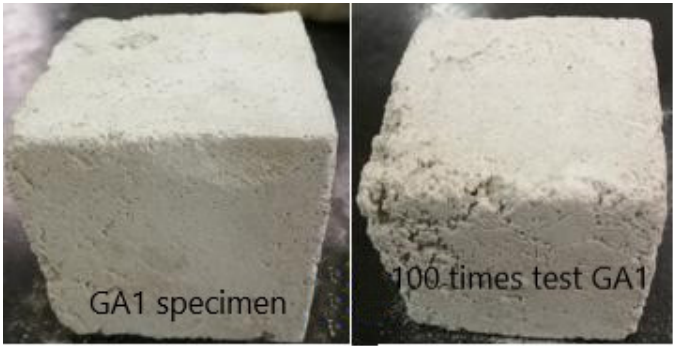
Figure 9. GA1 geopolymer and after 100 times test GA1 geopolymer.